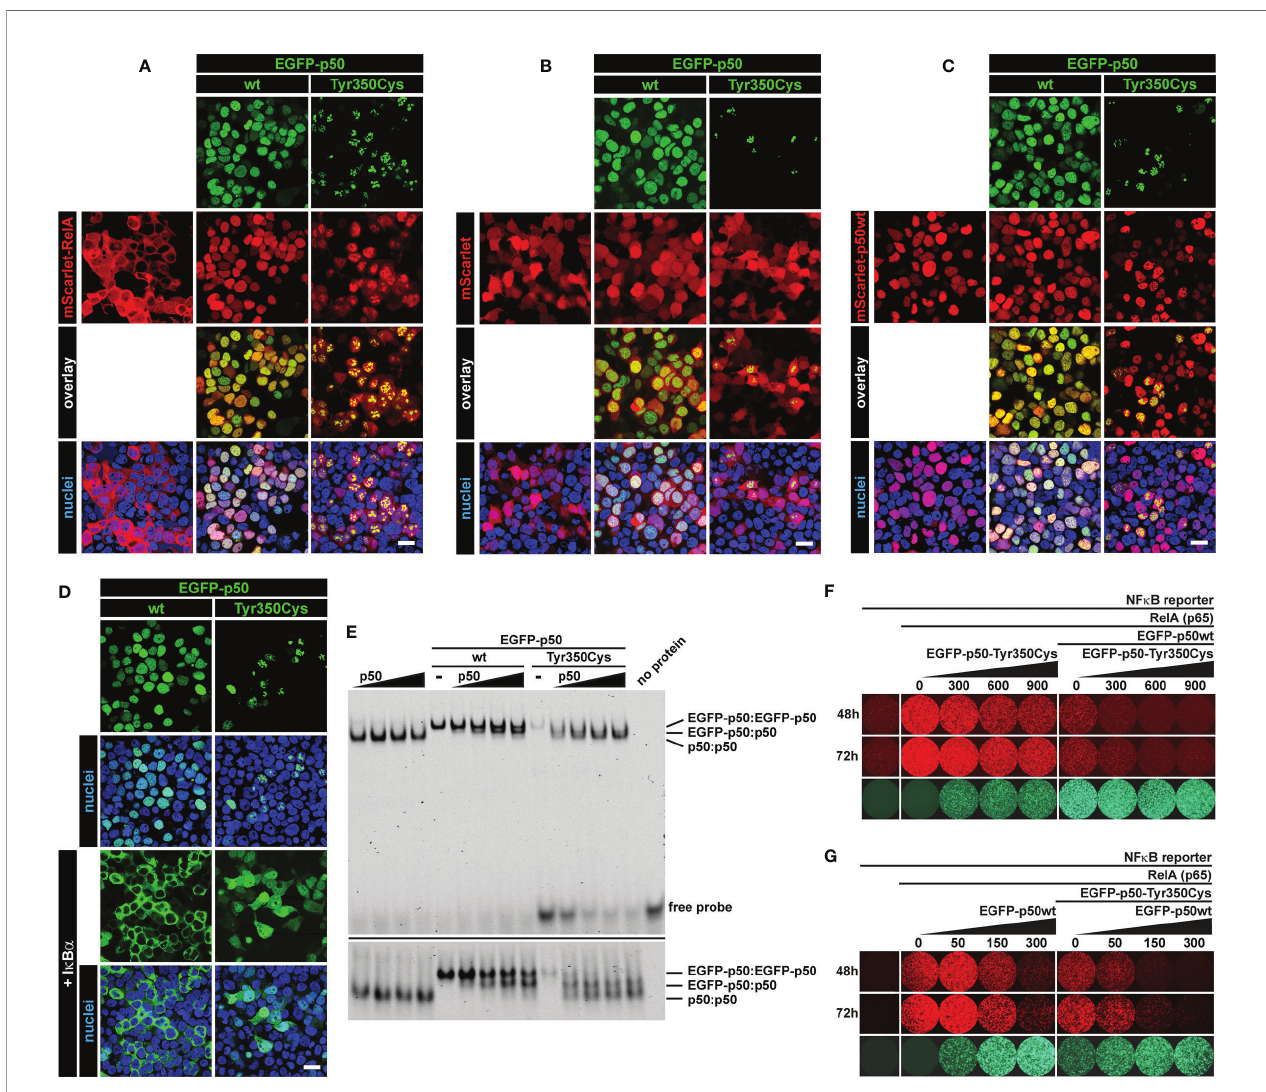
FIGURE 6 | Interaction of mutant p50-Tyr350Cys with RelA, p50 and I k B a . HEK293T cells were transiently (co-)transfected with the indicated vector constructs. DNA amounts were titrated in pre-experiments for each panel to enhance the visibility of protein-protein interactions. Representative examples are shown. (A) Confocal imaging shows most of the ectopically expressed mScarlet-RelA(p65) fusion protein (red) localizing to the cytoplasm. Strong and/or prolonged overexpression of RelA had cytotoxic effects (data not shown). Upon co-expression of wildtype p50 or p50-Tyr350Cys (green), RelA shows a nuclear localization and adapts the homogeneous pattern of wildtype p50 or the aberrant subnuclear accumulation of p50-Tyr350Cys. Nuclei were stained with Hoechst 33342 (blue). Scale bar: 20µm. (B) The empty mScarlet-C1 vector was used as a control. The non-speci fi c localization of mScarlet (red) is not in fl uenced by the wildtype or mutant EGFP-p50 fusion proteins (green). (C) The majority of the nuclear EGFP-fused p50-Tyr350Cys (green) accumulates in high intense spot-like structures, whereas most of the co-expressed mScarlet-fused wildtype p50 (red) remains unaffected and shows its typical homogeneous localization. (D) Co-expressed non-fused I k B a (not visible), a cytoplasmic inhibitor of NF- k B1 dimers, leads to a virtually complete cytoplasmic retention of wildtype EGFP-p50 (green). The retained EGFP-p50- Tyr350Cys (green) apparently undergoes cytoplasmic decay (as indicated by attenuated fl uorescence signals; not shown) whereas a proportion of the mutant protein localizes to the nucleus and adapts a uniform localization (at low abundance) or shows protein aggregation (at higher abundance). The fl uorescence intensities were adjusted for better visibility. (E) Increasing amounts of non-fused wildtype p50 (lower molecular weight) were co-expressed with wildtype or mutant EGFP-fused p50 (higher molecular weight) and DNA-binding competition was determined by EMSA. DNA-binding of p50(wt):p50(wt) homodimers, EGFP-p50(wt or mutant):p50(wt) mixed homodimers and EGFP-p50(wt or mutant):EGFP-p50(wt or mutant) homodimers is indicated by low, medium and high band sizes, respectively. An identical gel was prepared with an approximately 2.5-fold running time to separate the DNA-protein bands (lower panel). An intermediate sized band indicates the interaction of wildtype and mutant p50 (right panel). Diverse binding partner preferences are obvious. (F) Cells were transfected with the NF k B-reporter vector alone (100 ng) as background control, plus RelA(p65) (5 ng) to switch on reporter expression (tdTomato, red), and plus EGFP-fused p50 (300 ng) (green) to demonstrate its inhibitory effect on RelA-mediated reporter activity. In the presence of p50 (and thus repressive p50:p50 homodimers) reporter activity is further repressed by increasing relative amounts of mutant p50-Tyr350Cys, whereas p50-Tyr350Cys alone has a dose-dependent attenuating effect. Numbers indicate transfected DNA amounts (ng) (G) Reverse promoter reporter experiment with increasing relative amounts of wildtype p50 alone or in the presence of co-transfected p50-Tyr350Cys (300 ng). The dose-dependent repressive effect of wildtype p50 is further intensi fi ed by the co-expressed